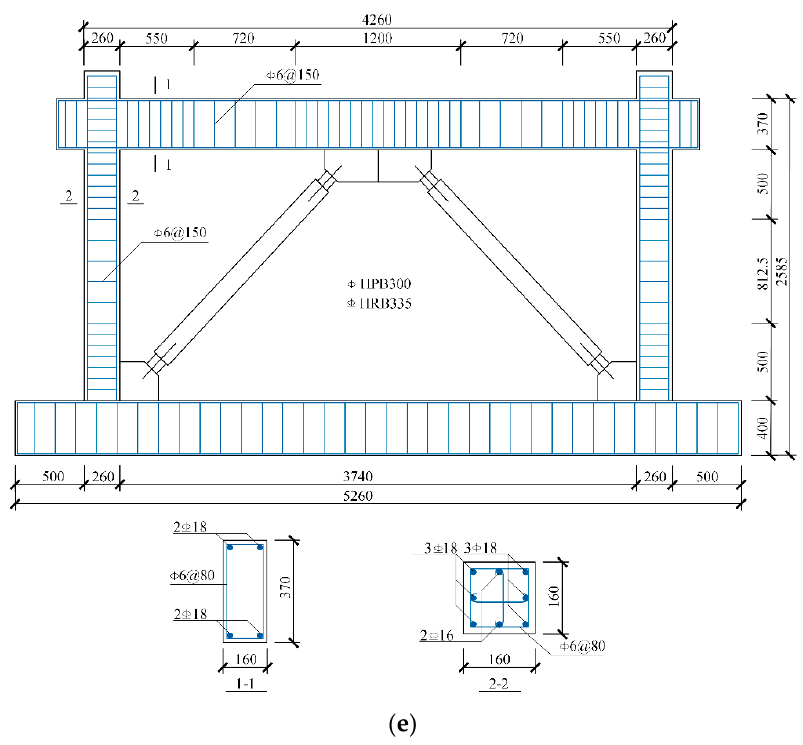
Figure 6. Sketch diagram: ( a ) BLY225-1, ( b ) V1, ( c ) V2, ( d ) BRBCF3, and ( e ) BRBF3 and BRBF5. Table 4. Test information of BRB frame substructures.